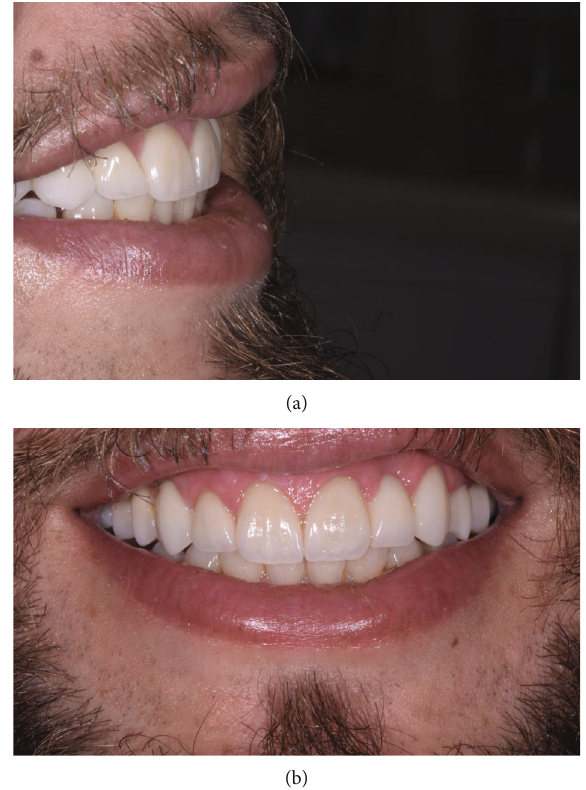
Figure 6: (a) Extraoral lateral view of the fi nal restorations illustrating the desired esthetic outcome. (b) Extraoral frontal view of the patient smile with the fi nal full-coverage